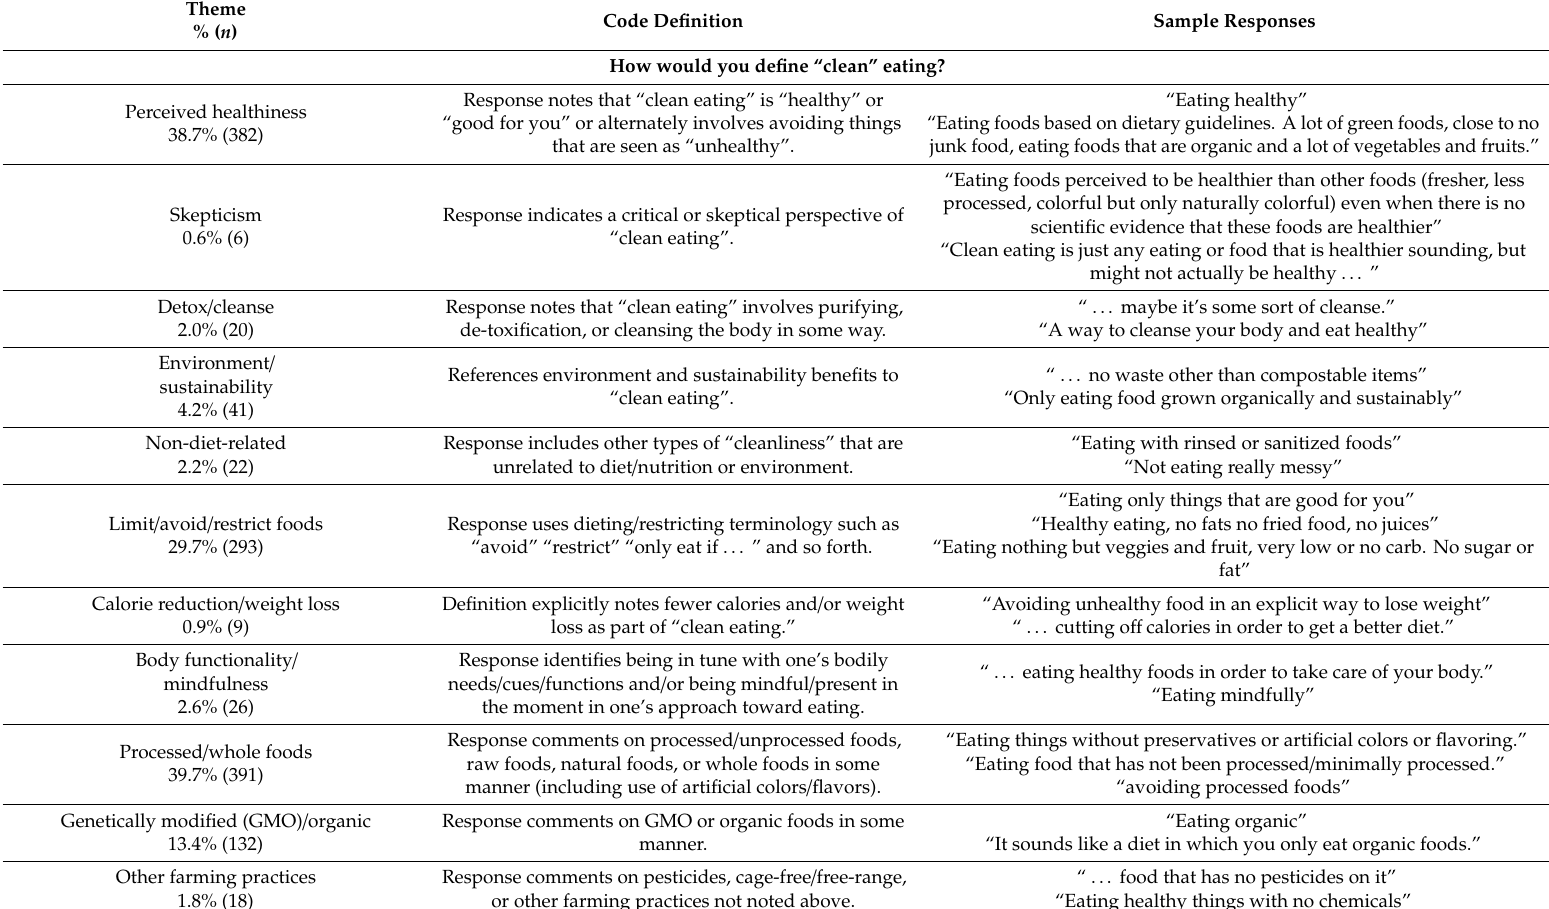
Table 3. Definitions of “clean” eating, opinions, and perceptions of healthiness vs.